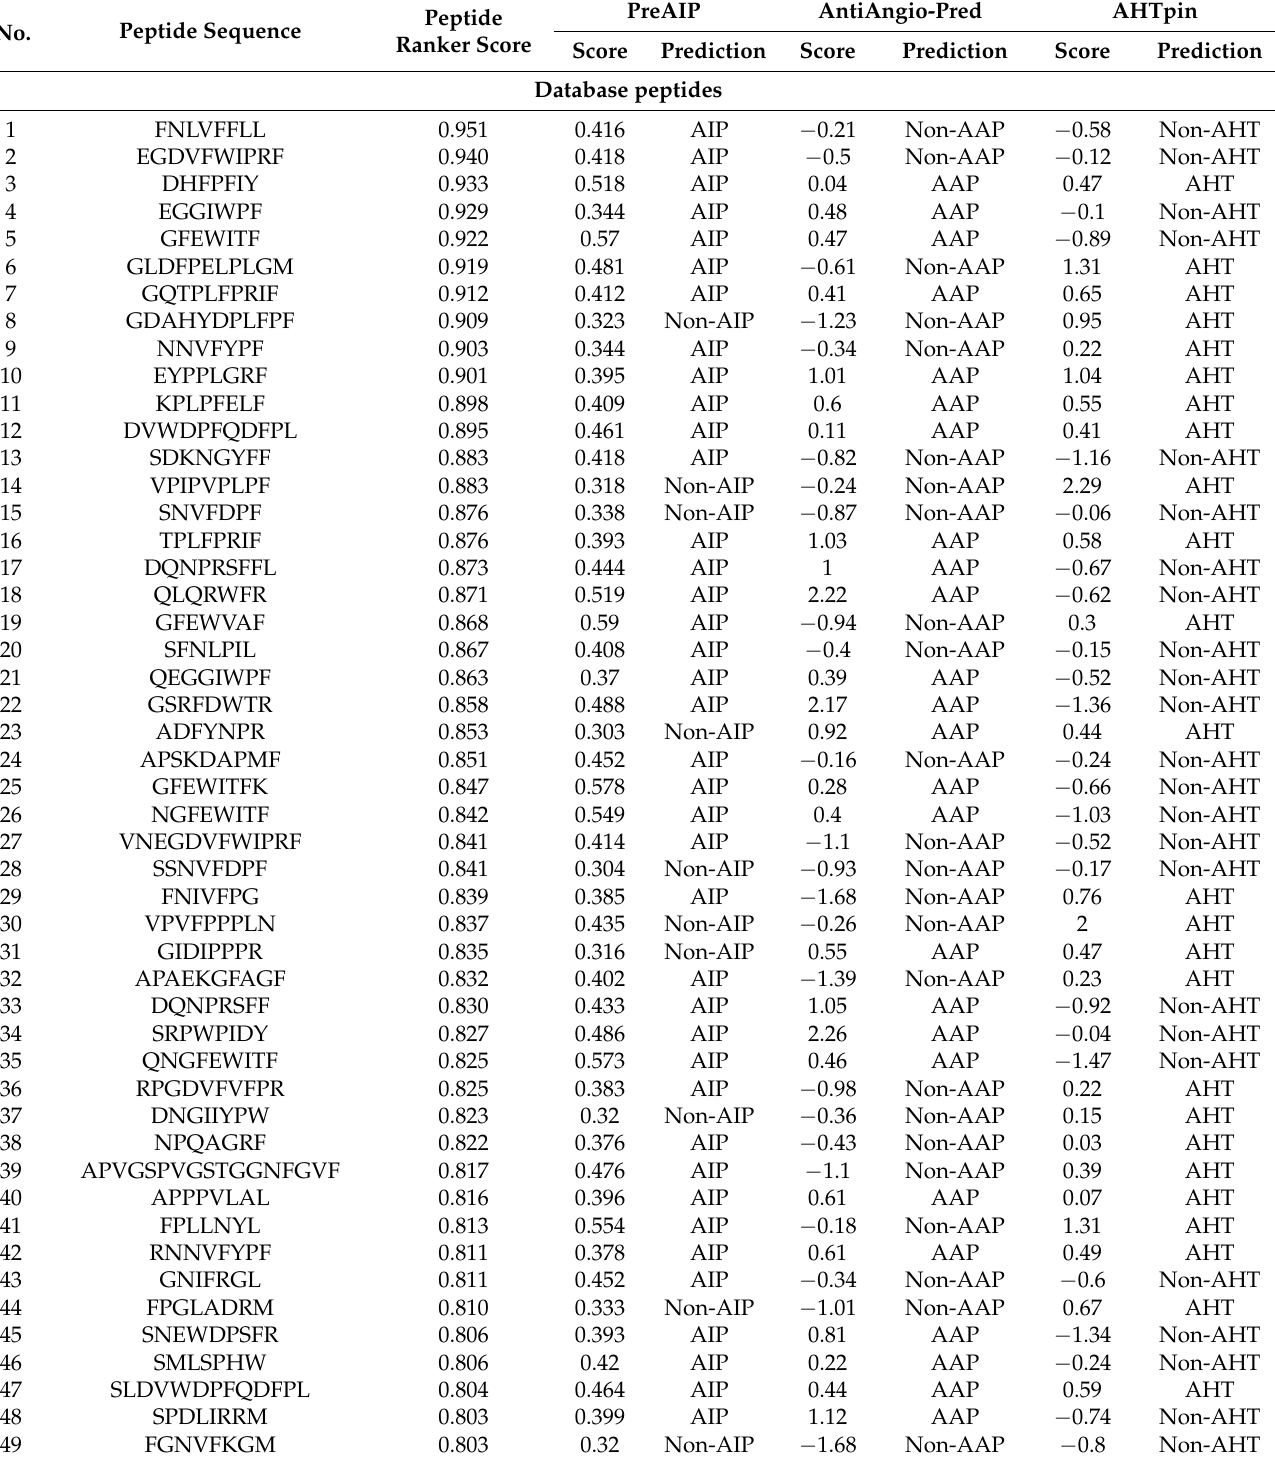
Table 1. In silico analysis results of selected peptide sequences from chia